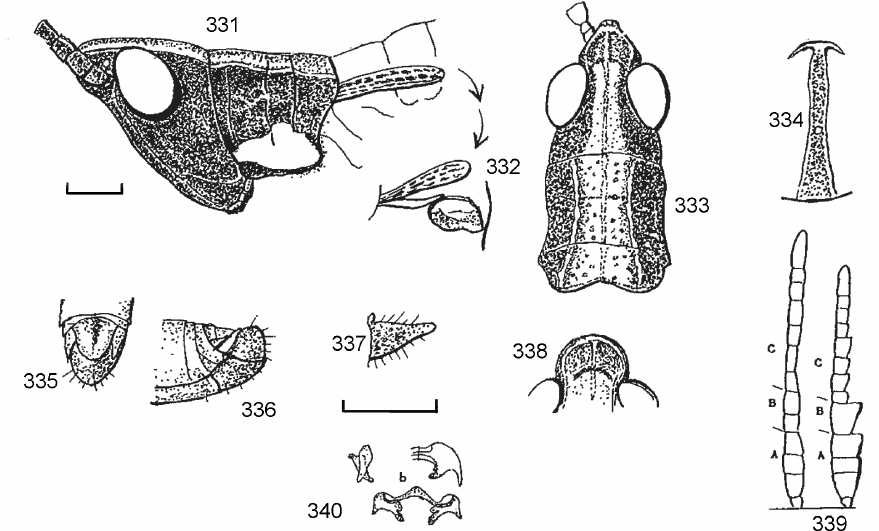
Figs 331–340. Tribe Pargaini. Acteana. Figs 331–340. Acteana alazonica male: See also Fig. 67: 331. Lateral view head, pronotum, and tegmen; 332. Tegmen raised to show tympanum and wing; 333. Head and pronotum from above; 334. Frontal ridge; 335. Abdominal apex from above; 336. Abdominal apex from side; 337. Left cercus; 338. Female, apex of head from above; 339. Male, female antennae; 340. Epiphallus from dorsal and lateral angles. Scale lines represent 1 mm: that next to Fig. 340 applies to Fig. 340 and 337; that below Fig. 331 applies to all the